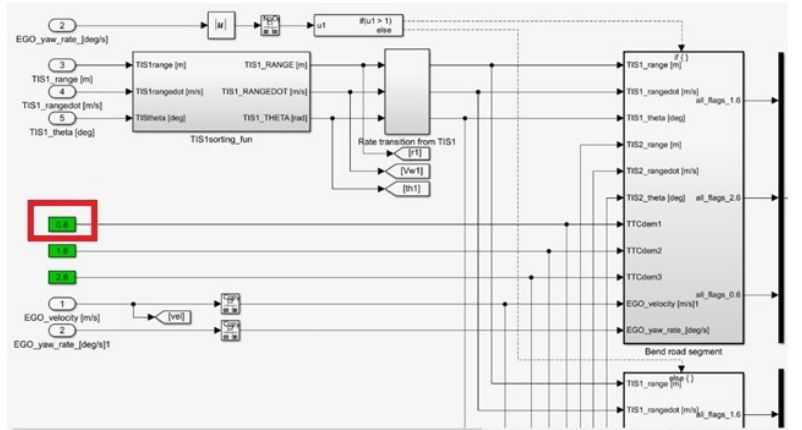
Figure 10. Model of TTC variable that starts full braking.